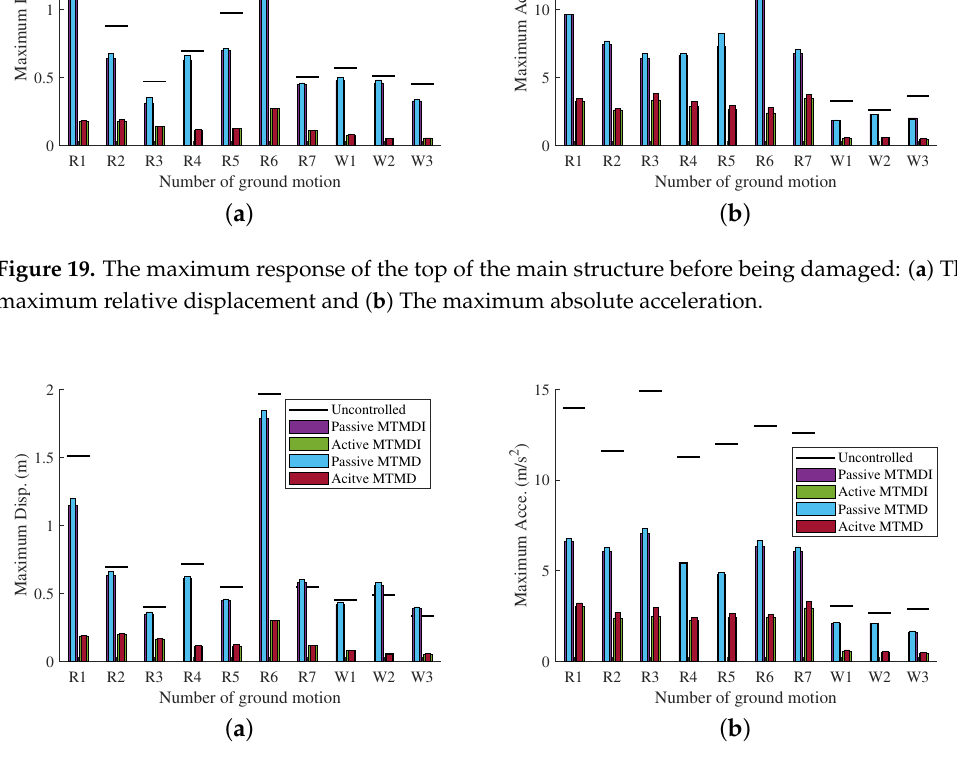
Figure 20. The maximum response of the top of the main structure after being damaged: ( a ) The maximum relative displacement and ( b ) The maximum absolute